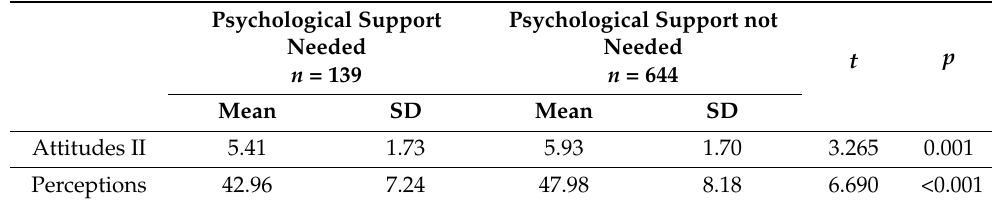
Table 5. Working perceptions and attitudes towards work of the health professionals according to whether or not they required psychological help.